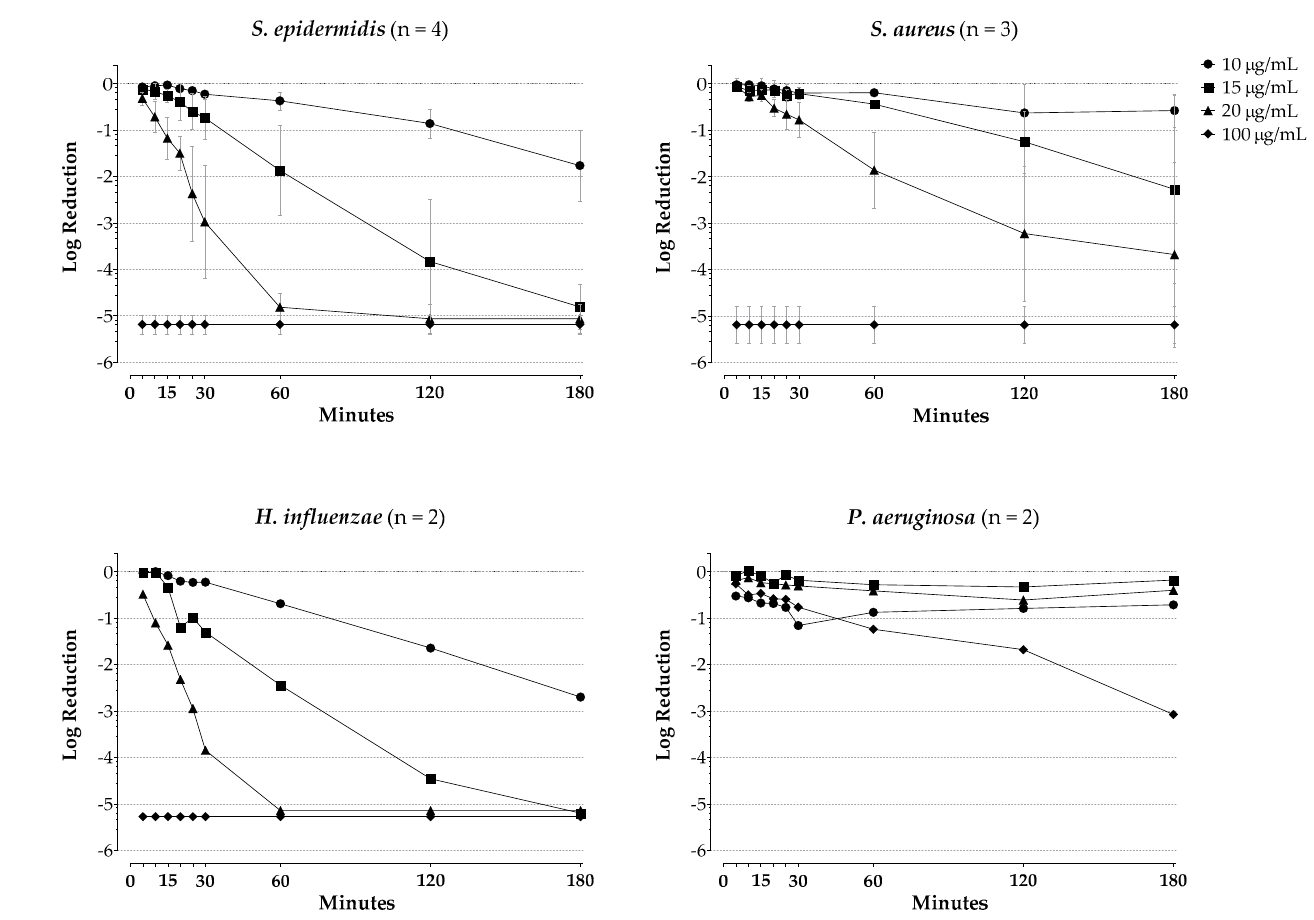
Figure 1. Log reductions in viable cells over time with increasing concentrations of BAK alone. Starting (0 min) viable cell densities for each isolate were ~10 5 CFU/mL. Each plot point represents the mean ( ± SD) ( S. epidermidis and S. aureus ) or average ( H. influenzae and P. aeruginosa ) for the isolates tested of each species.